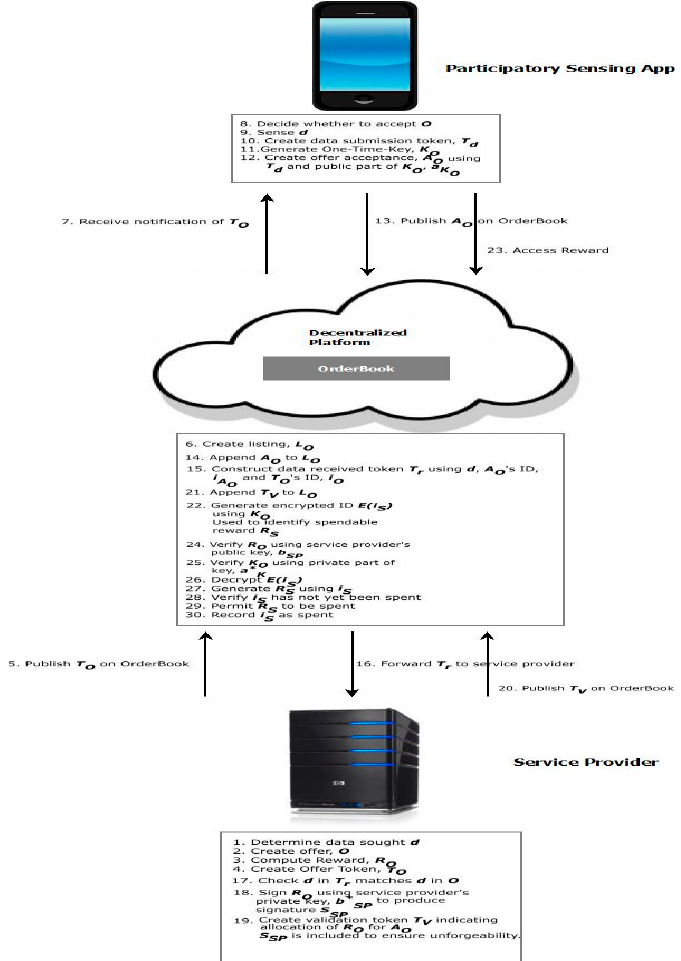
Figure 2. Privacy-Aware Incentivization platform.